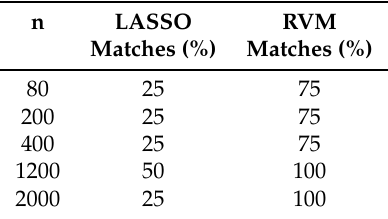
Table 3. Matches in percentage with the real indices of variables selected by LASSO and RVM for dataset (f). n LASSO